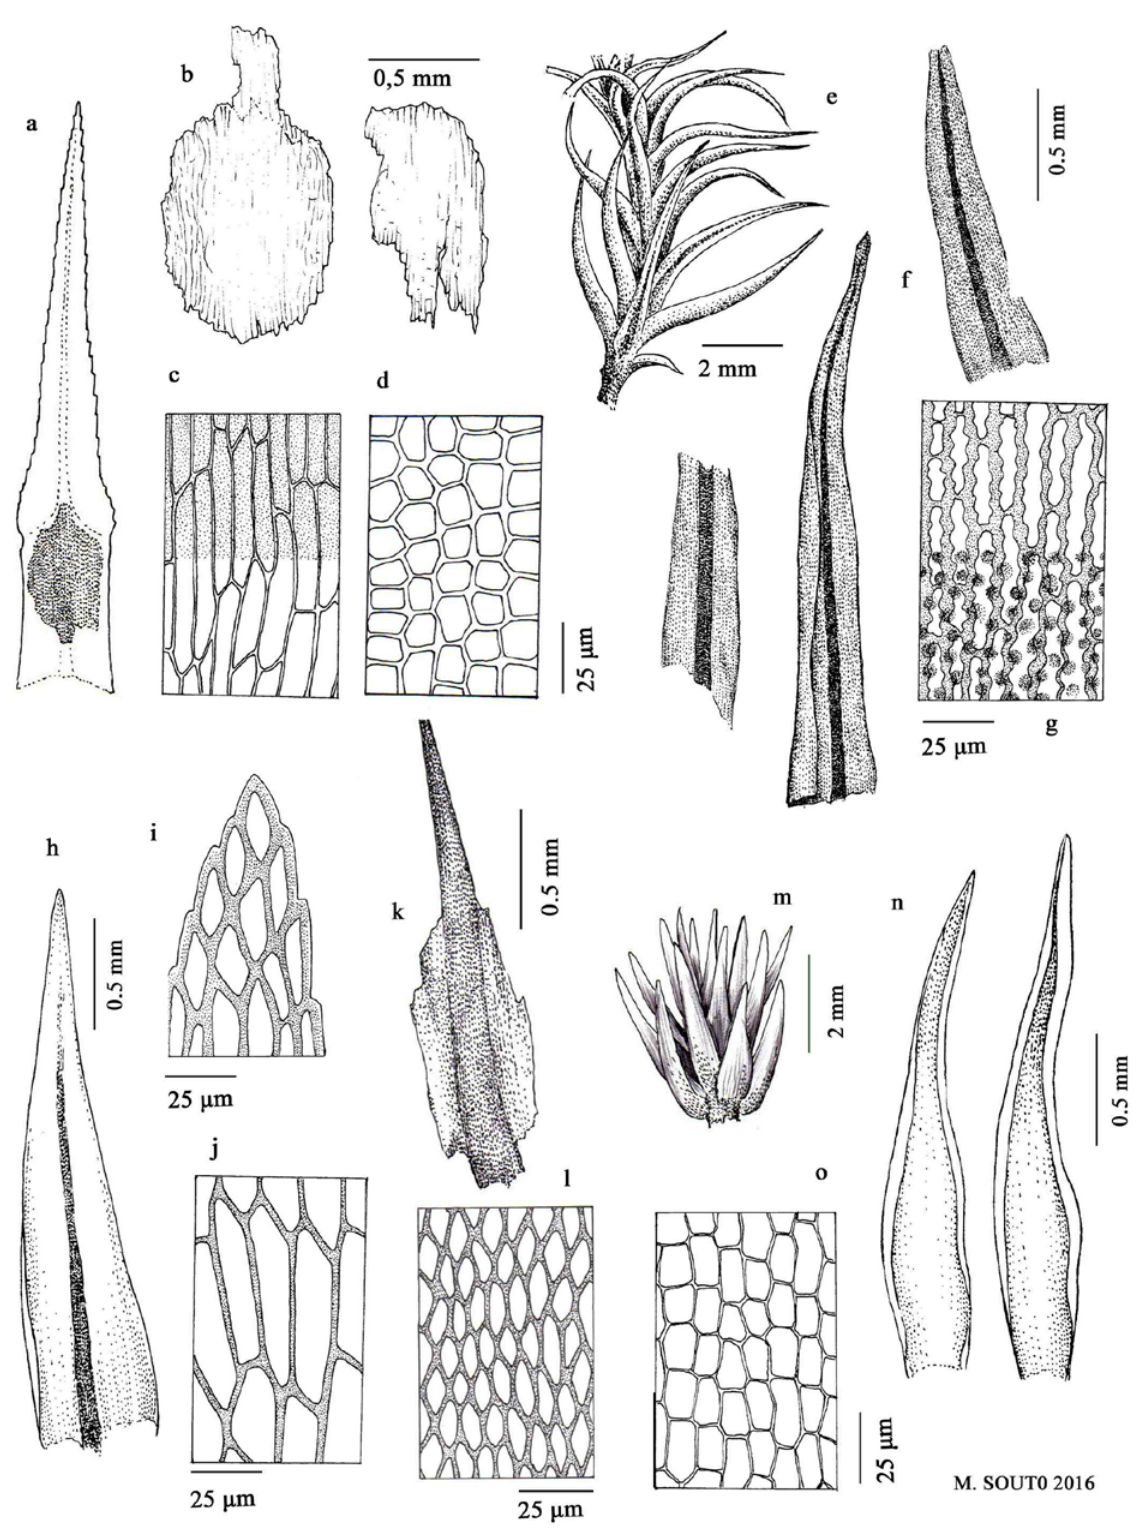
Figure A4. Polytrichum sp.: a) reconstruction of a leaf based on one of the studied macrofossils (dark area), b) leaf base fragment, c) cells of leaf base, d) upper cells of a leaf fragment; Racomitrium lanuginosum : e) fragment of a branch with leaves, f) leaves, g) mid-leaf cells; Dicranum scoparium : h) leaf, i) leaf apex cells, j) mid-leaf cells; Campylopus sp.: k) leaf, l) mid-leaf cells; Leucobryum juniperoideum : m) stem tip with leaves, n) leaves, o) mid-leaf